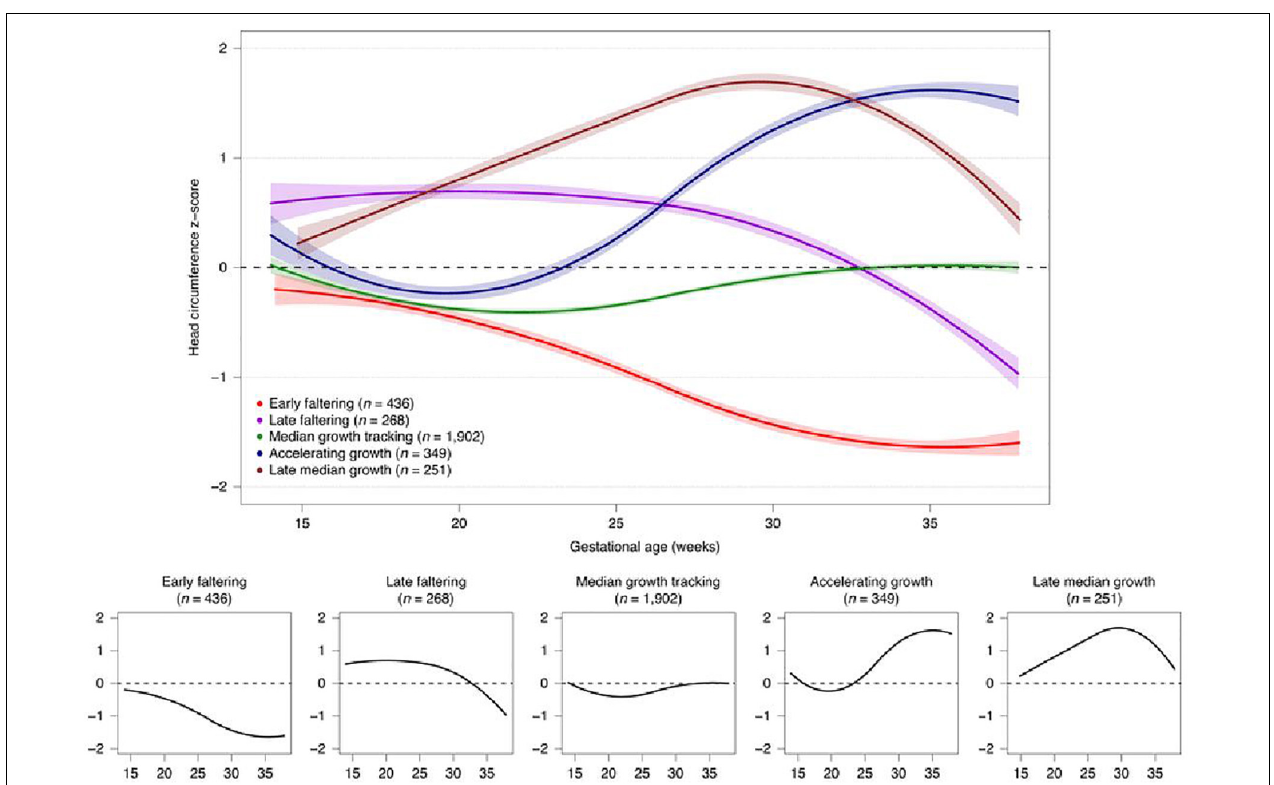
FIGURE 6 | Fetal cranial growth trajectories in the INTERBIO-21st study (Villar et al., 2021a).